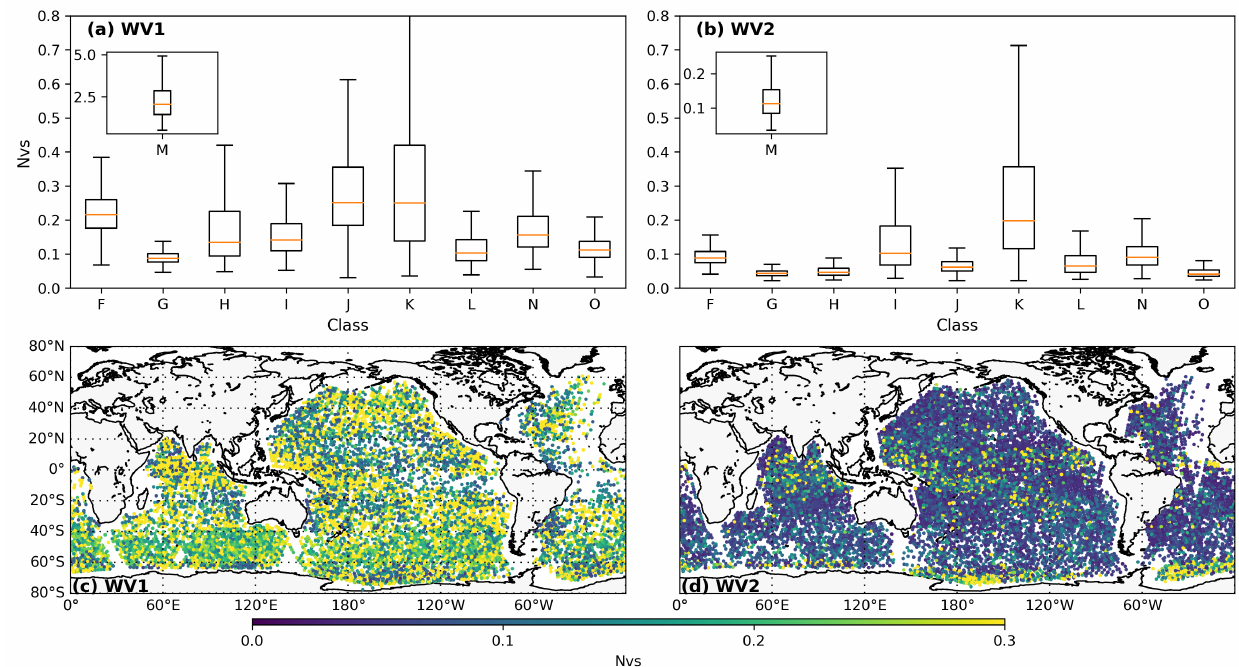
Figure 4. (Top) box plot of Nvar for the ten labeled classes at ( a ) WV1 and ( b ) WV2. (Bottom) global map of the labeled Nvar at ( c ) WV1 and ( d ) WV2.